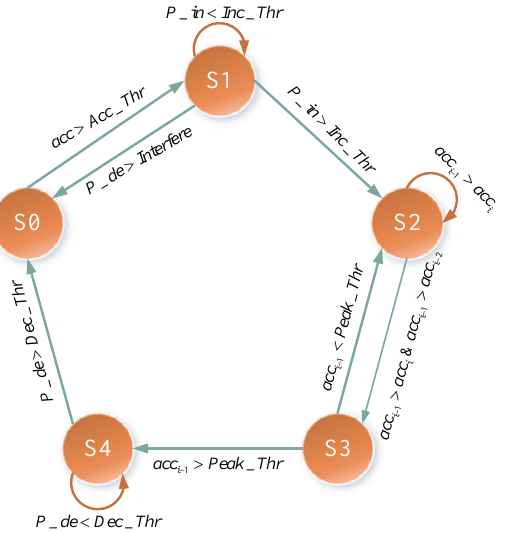
Figure 5. The gait detection algorithm, based on IFSM.